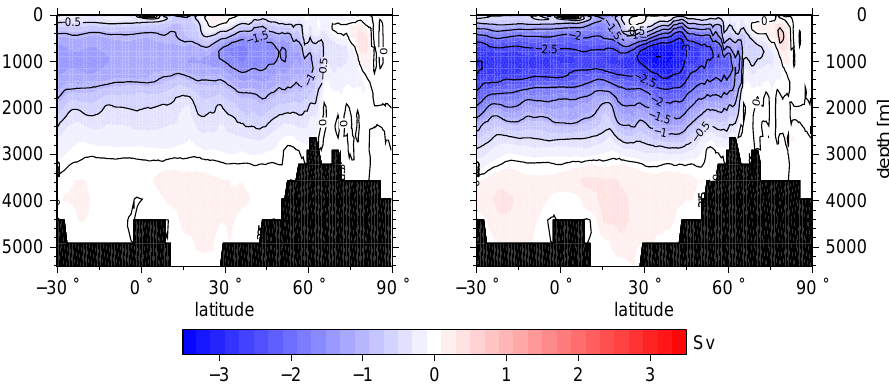
Fig. 6. Differences of the zonally integrated vertical stream function in the North Atlantic in Sv ( 10 6 m 2 / s) for a) Holocene - pre-industrial and b) Eemian - pre-industrial.